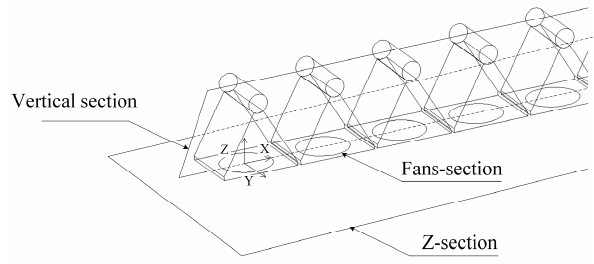
Figure 14. The vertical section of air-cooled unit in row 4, Z-section and fans section.